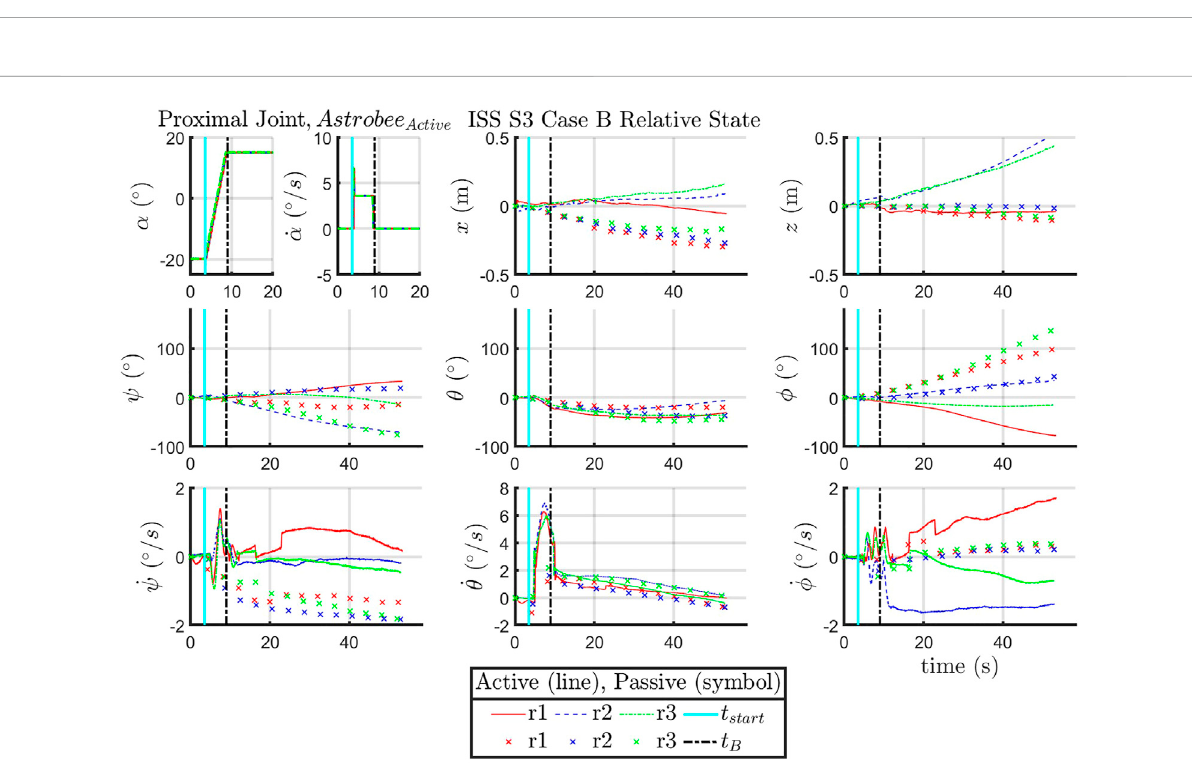
FIGURE A2 ISS: State data collected case